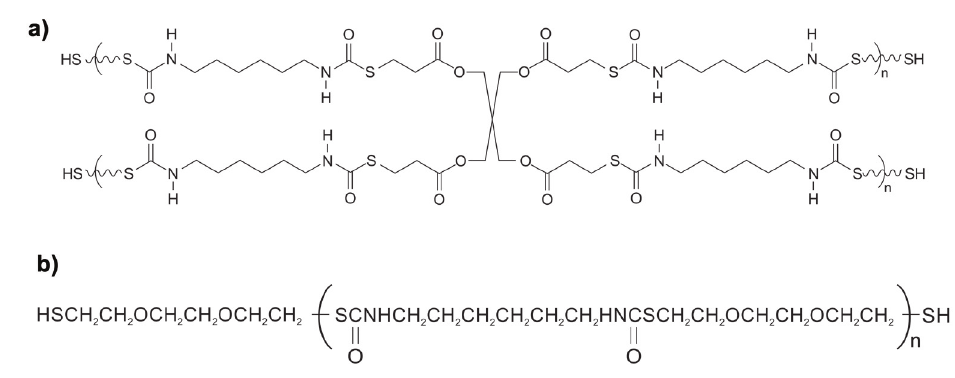
Figure 1: (a) Multifunctional polythiourethane MPTU and (b) Difunctional polythiourethane